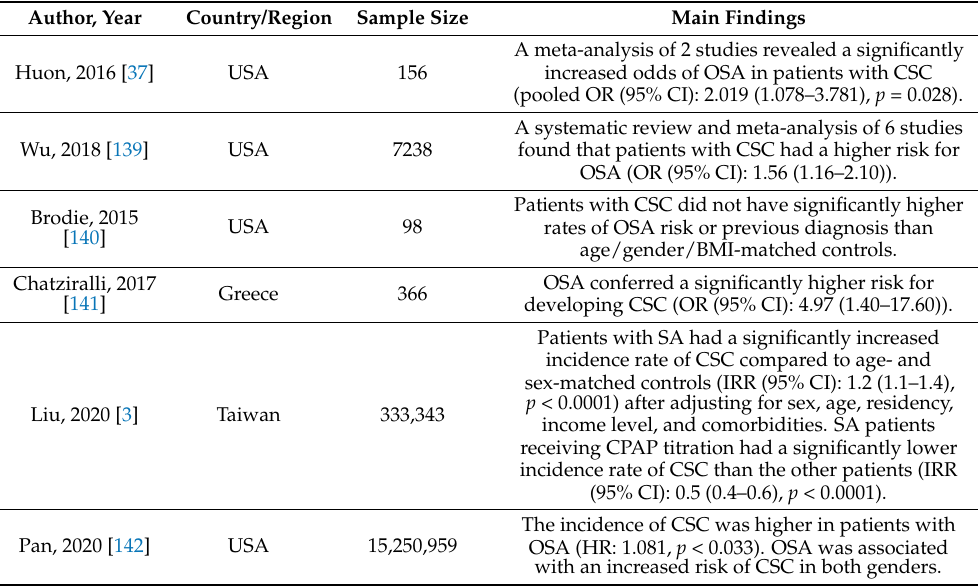
Table A5. Summary of the major studies evaluating the association between OSA and